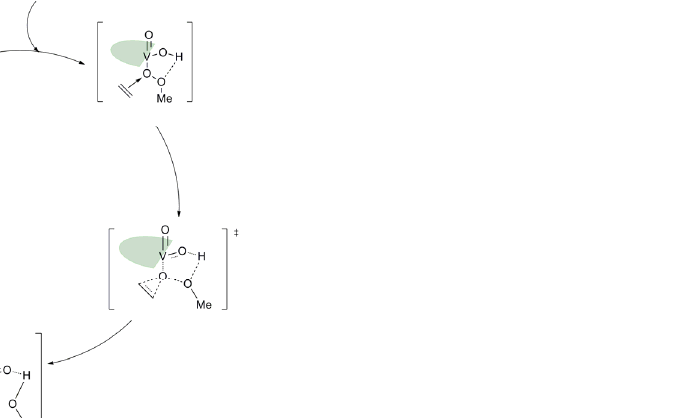
Figure 20. Schematic representation of vanadium complexes containing pyridoxal fragments being monomeric when containing hydrazide moieties and dimeric with thiosemicarbazones. Figure 21. Schematic catalytic cycle proposed after DFT calculations with the [VO 2 (LH)] (X = C-OH) complex. The ligand was schemed with the green symbol.